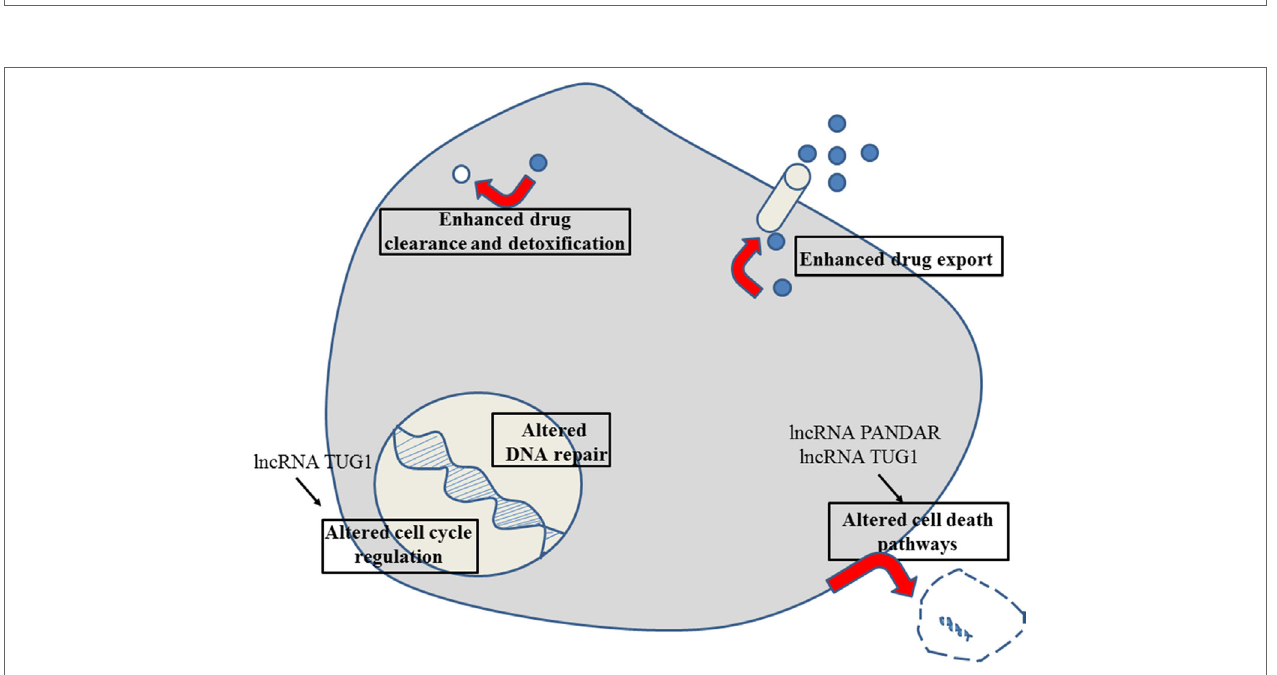
FiGURe 7 | Role of non-coding RNAs for the different reasons that can cause resistance to anticancer drugs in cholangiocarcinoma. For details about target genes and regulated protein expression by the non-coding RNAs, see text.